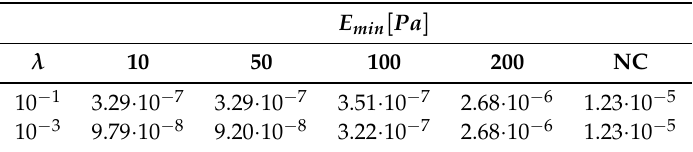
10 3 . · 10 3 . The reference case with no control is labeled ·